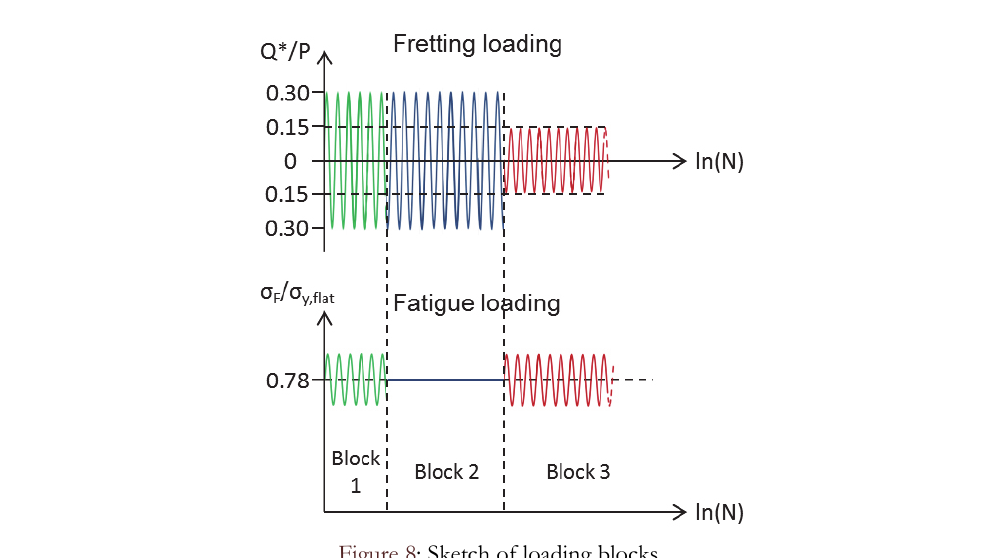
Figure 8: Sketch of loading blocks.